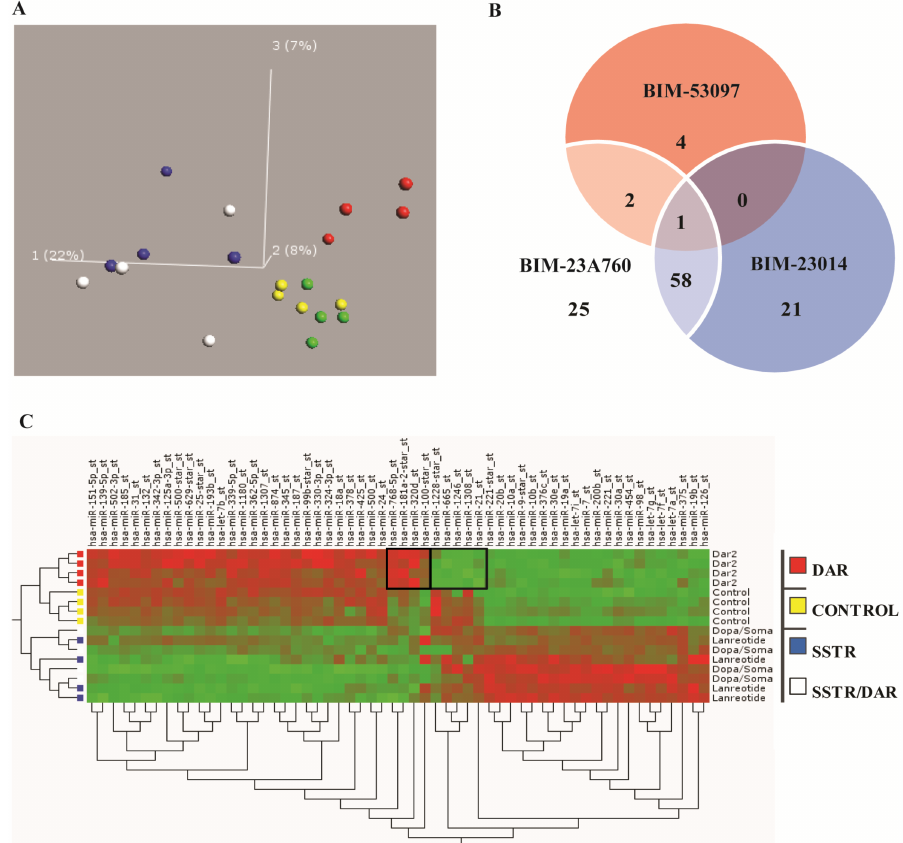
Figure 3. PCA shows specific miRNA expression depending on receptor activation. ( A ) The unbiased PCA separates the samples based on variation in the expression of miRNA in each sample. In the first dimension samples treated with BIM-23014 (blue—SSTR agonist) and BIM- 23A760 (white—SSTR and dopamine receptor D2 (DRD2) chimeric agonist) separated from the others. BIM-23023 (green—SSTR) did not separate from the control (yellow). Also in the first dimension BIM-53097 (red—DRD2) did not separate from the controls. However, in the third dimension the BIM-53097 (red—DRD2) treated samples clearly separated from the controls. The percentage indicates how much of the total variation is present in each dimension. In this experiment 22% of the total variation of miRNA expression is found in the first dimension, 8% in the second and 7% in the third. The two most potent inhibitors of growth BIM-23A760 and BIM-23014 group together, the DRD2 agonist and the least effective growth inhibitor separates by itself. ( B ) The Venn diagram shows the miRNAs shared between the different analogue treatments and that the number of miRNAs shared between BIM-23A760 (SSTR-DRD2) and BIM-23014 (SSTR) are greater than BIM-53097 (DRD2). ( C ) On the right side of the map is the clustering of treatment where DRD2 and controls separate from chimeric compound BIM-23A760 (SSTR-DRD2) and BIM-23014 (SSTR). Furthermore it seems to separate controls and DRD2. Notice in the middle of the control/DRD2 treatment, there is a small fraction of miRNA which seems to be controlled by dopamine alone and different from the control